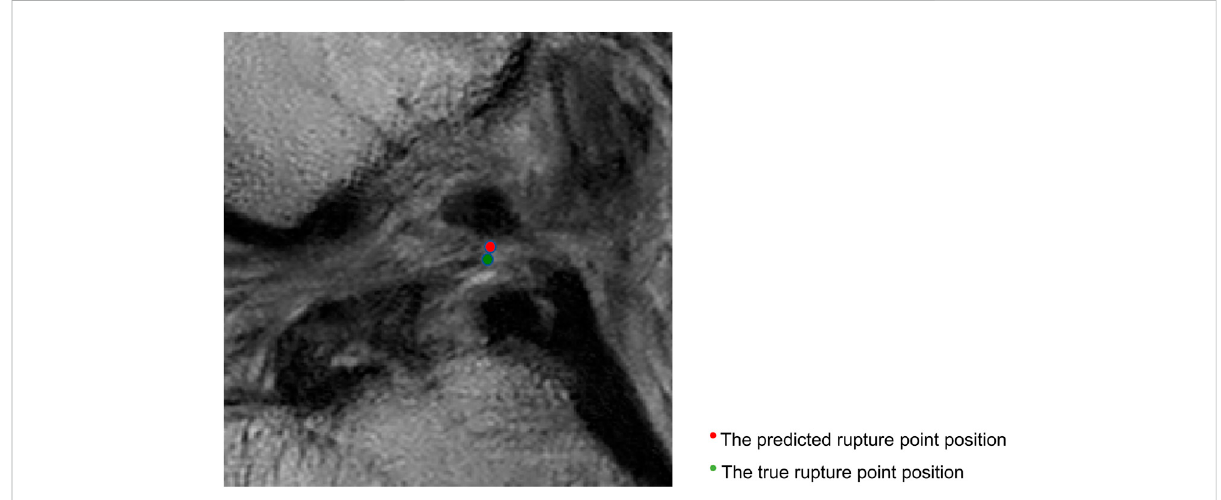
FIGURE 5 Sagittal views of the cropped MR image, correct localization and classi fi cation. The predicted rupture point is marked by red circle, while the true rupture point is green . The model predicted a correct localization, and the system shows a correct classi fi cation (the middle